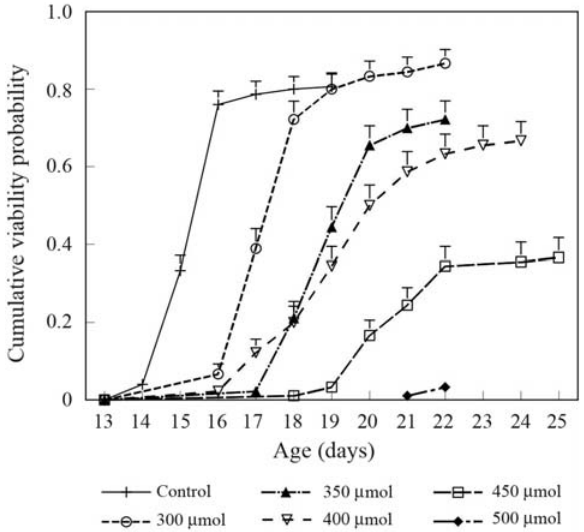
Figure 2 - Diphenyl diselenide molarity and Drosophila melanogaster vi- ability and developmental delay curves for the pupa to adult stage. For eachoffivereplicates,30eggswereplacedonbanana-agarcontainingdif- ferent molarities of diphenyl diselenide and assessed for viability every day up to adulthood, the Y-axis representing the percentage of viable lar- vae surviving to this stage. Table 2 - Pairwise chi-squared ( χ 2 ) comparisons of the D. melanogaster pupae to adult developmental rate for flies fed on banana-agar